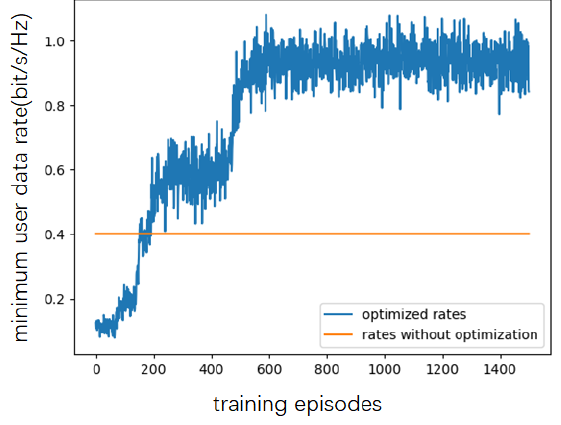
Figure 12. Comparison with non-optimized